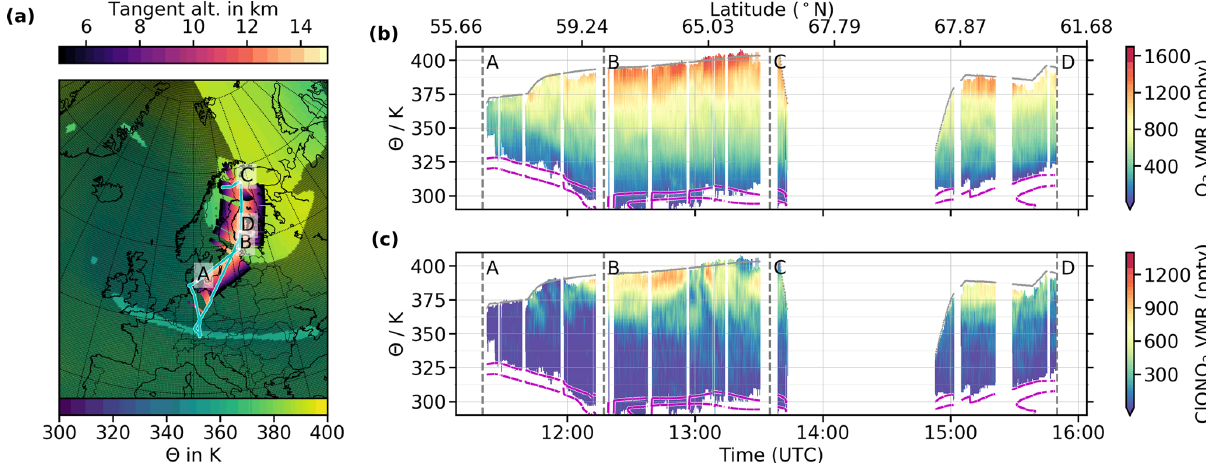
Figure 7. As in Fig. 5 but for flight PGS21 (18 March 2016). The underlain map (bold black lines show coastal lines, regular black lines country borders, and dotted lines indicate a latitude by longitude grid) shows the European continent and is centered at 60 ◦ N latitude and 10 ◦ E